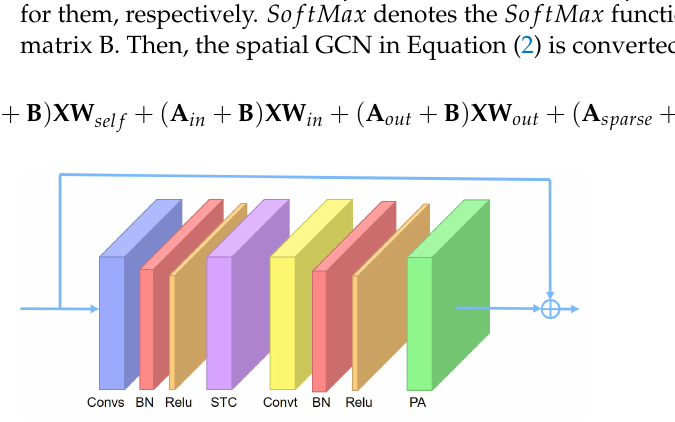
Figure 5. A basic block consists of Convs, STC, Convt, PA, and other operations: batch normalization (BN), ReLU, and the residual block. Convs represents the spatial GCN, and Convt represents the temporal GCN, both of which are followed by a BN layer and a ReLU layer. STC denotes the STC-attention module proposed in MS-AAGCN. PA is the part attention